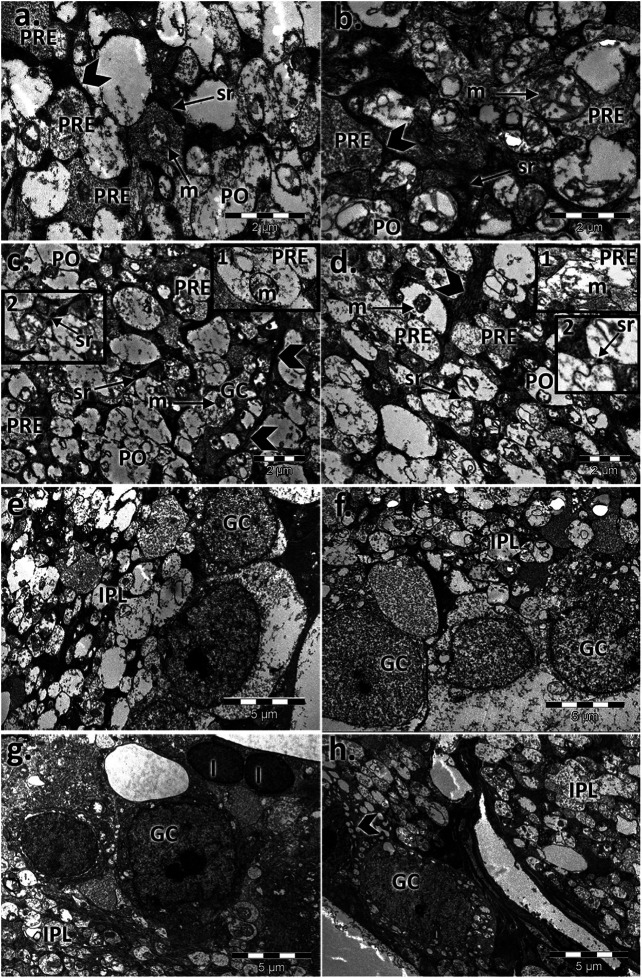
Electron micrographs showing the ultrastructural features of the inner plexiform layer (IPL) and ganglion layer (RGL) of the young and aged retinas. Ultrathin section through the inner plexiform layer (IPL) showing different types of processes in (A) the control male, (B) control female, (C) aged male retina, and (D) aged female retina; presynaptic endings (PRE); large mitochondria (m); postsynaptic endings (PO); Müller processes (MP) (arrowhead); detail 1: presynaptic endings (PRE) with rarefied mitochondrial cristae and a few microvesicles—aged males (C) and females (D); detail 2: synaptic ribbons (arrows) in a presynaptic bag (PRE)—aged males (C) and females (D); electron micrographs of a section through the ganglion cell layer in (E) the control male, (F) control female (G), aged male retina (H), and aged female retina; ganglion cell (GC), inner plexiform layer (IPL), apoptotic cell (arrowhead), and lipofuscin granules (l). Figures are representative of n = 10 electron micrographs for each individual/group.